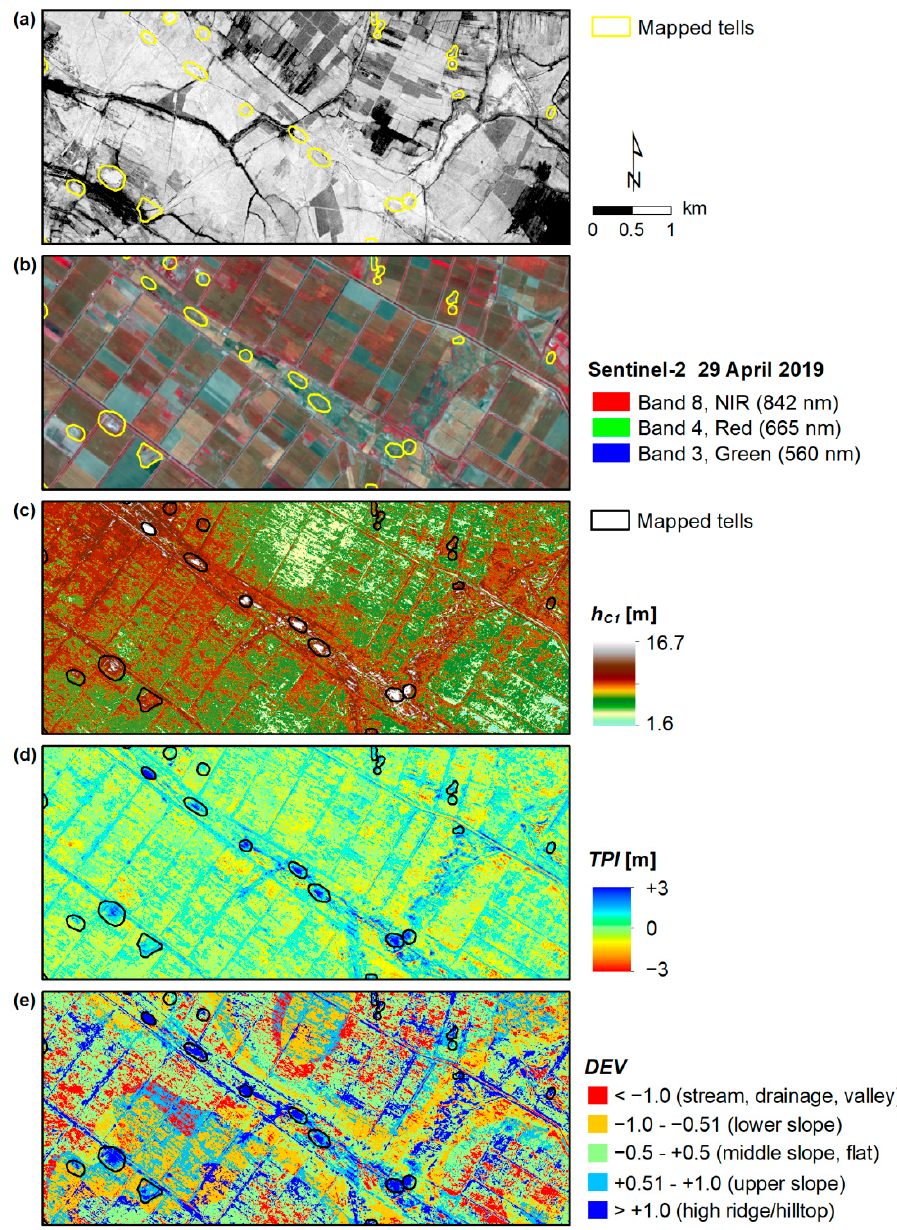
Figure 16. Zoomed view of the northernmost part of the test area as depicted in ( a ) CORONA imagery, ( b ) Sentinel-2 false-colored image (contains Copernicus Sentinel-2 data, 2019), ( c ) CartoSat-1 DSM (©GAF AG. Includes material ©Antrix, distributed by GAF AG), and its derivatives: ( d ) Topographic Position Index ( TPI ) and ( e ) DEViation from mean elevation ( DEV ).